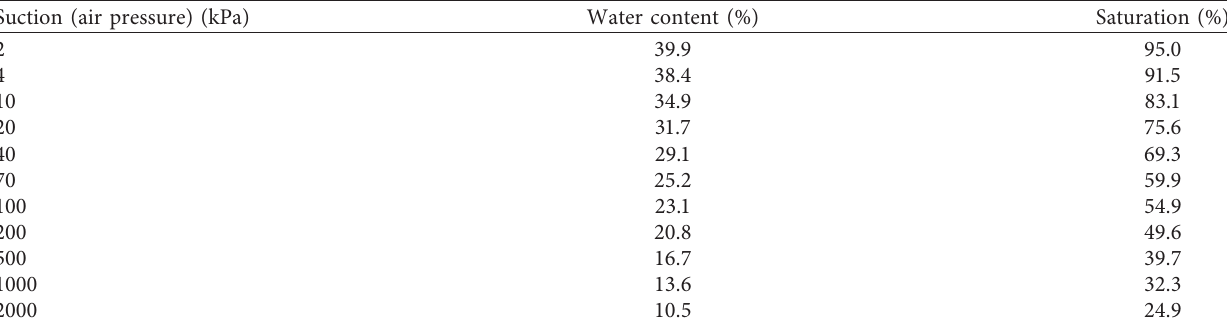
Table 3: The soil-water characteristic curve test data of the loess samples.